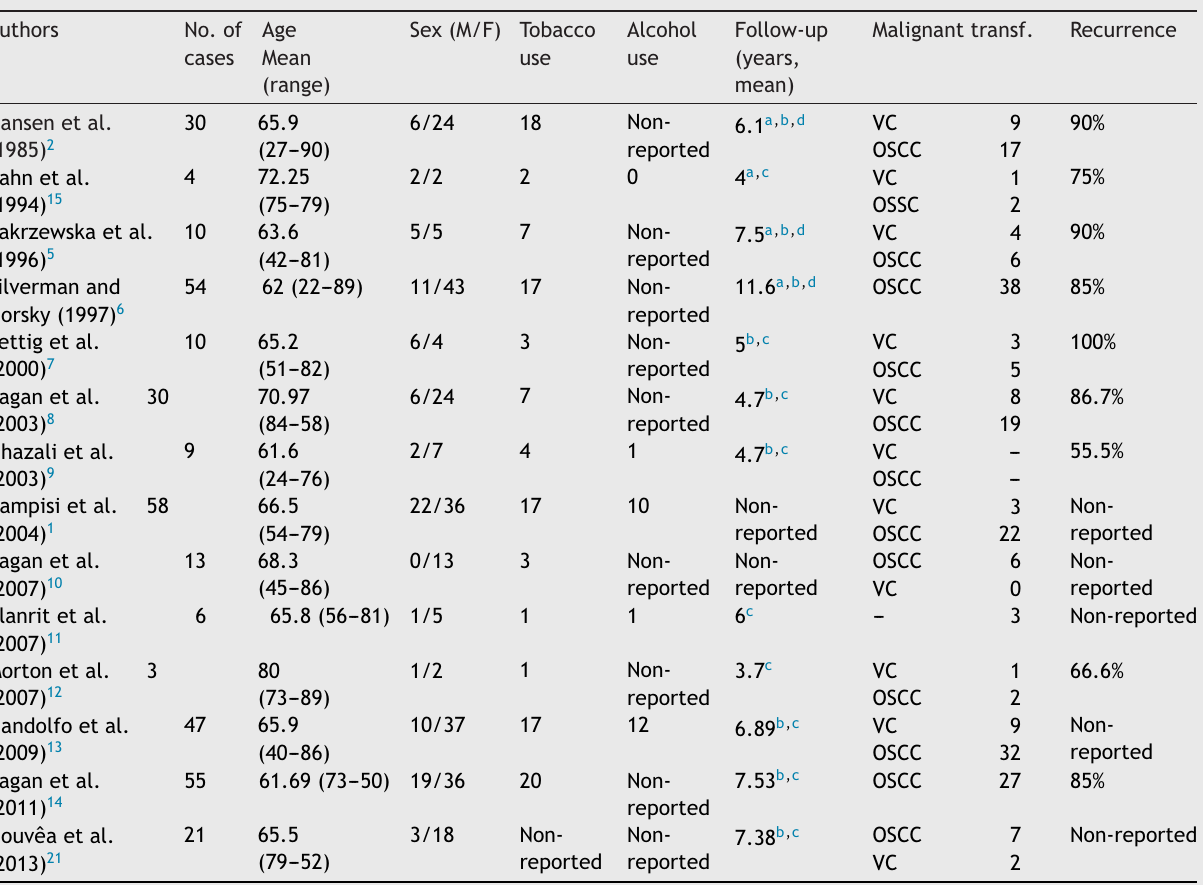
Studies of PVL cases